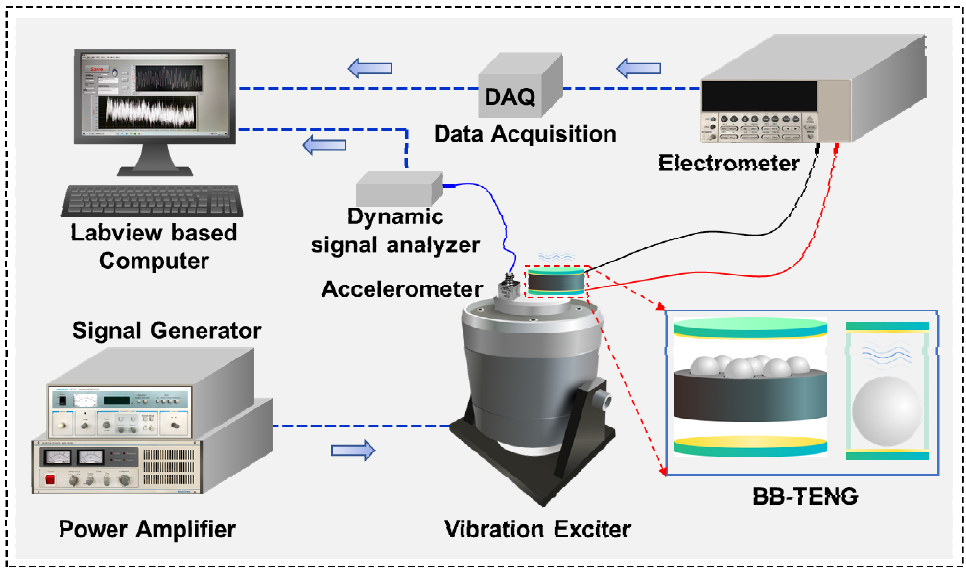
Figure 2. Apparatus for electrical signal test of the BB-TENG sensor.